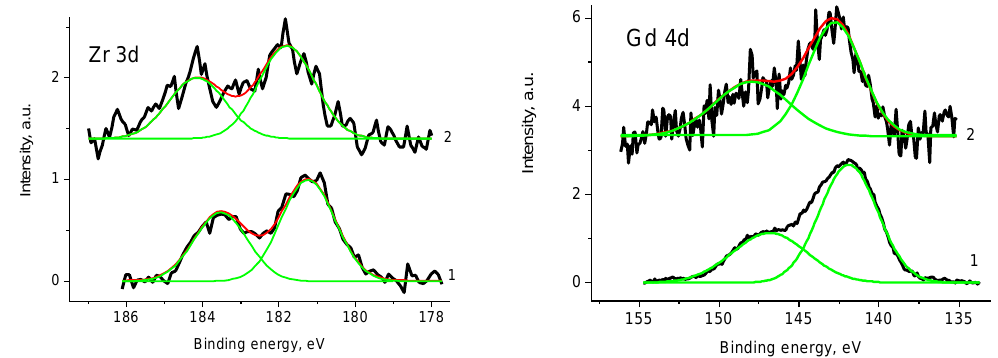
Figure 21. The Zr 3d and Gd 4d Photoelectron spectra samples 1 (1) and Pt/1 (2) (initial spectra – black, basic curves – green, resulting curves – red).